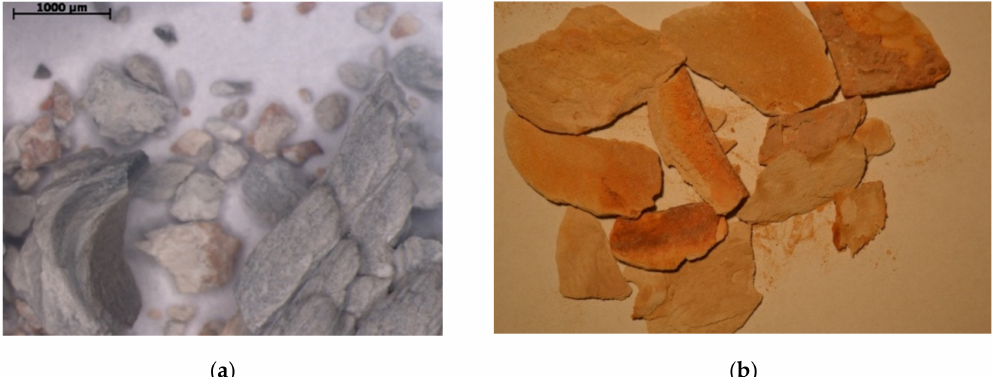
Figure 3. Deposits from: ( a ) head (optical microscope) and ( b )